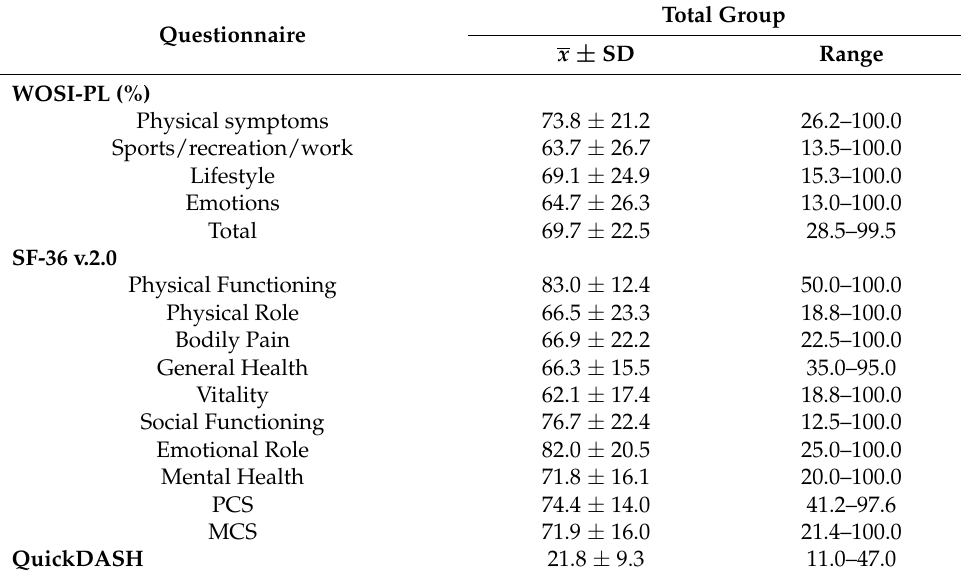
Table 2. Absolute values of all scores ( n = 74).